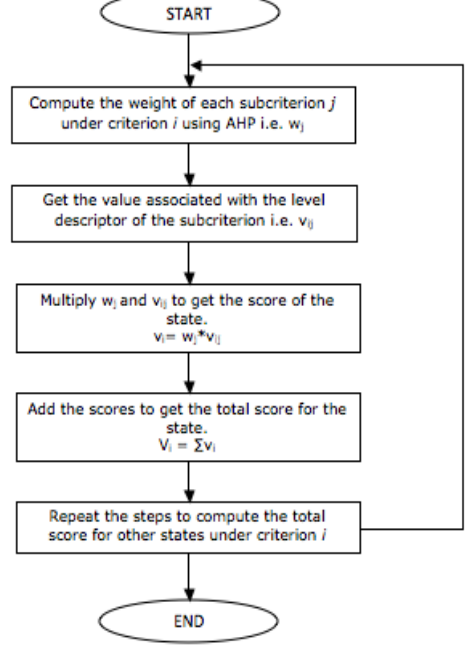
Figure 4. Flowchart showing the steps involved in the performance appraisal